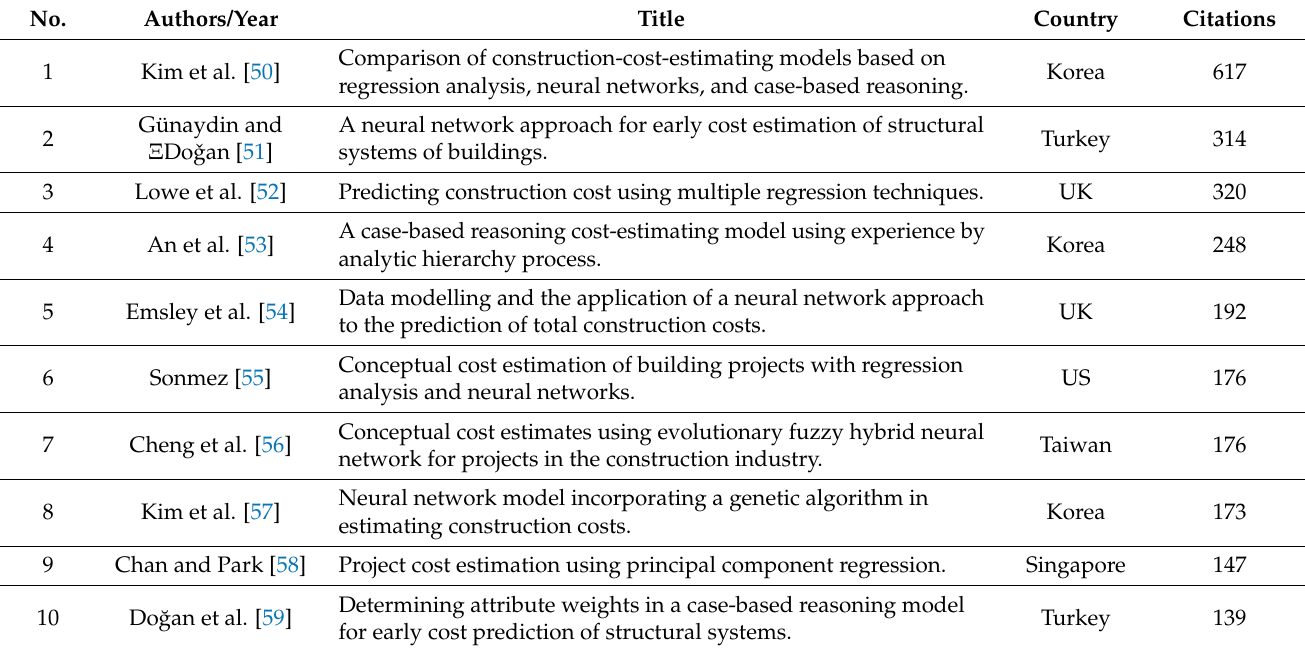
Table 1. Most cited